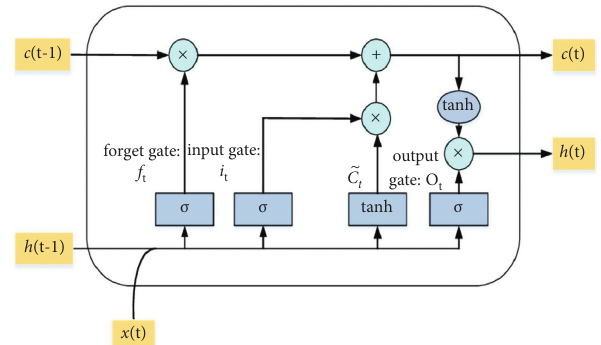
Figure 2: Basic architecture of LSTM when being used for time- series prediction in a supervised model. The figure is recreated from